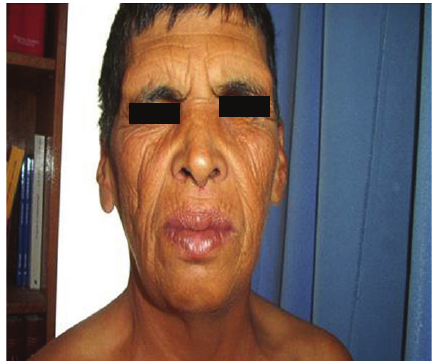
Figure 2: Frontal facial appearance.